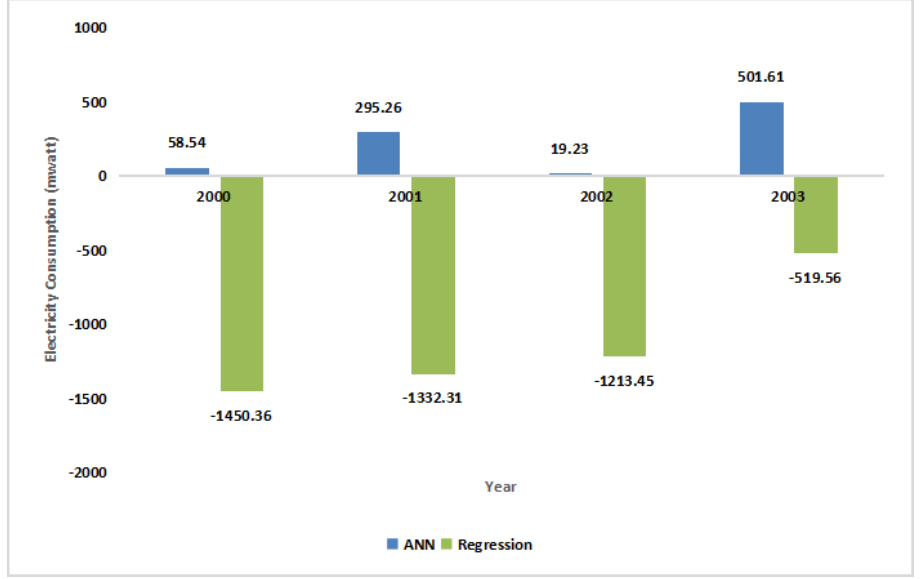
Figure 6. Analysis ofelectricity consumption variation using ANN and regression models.